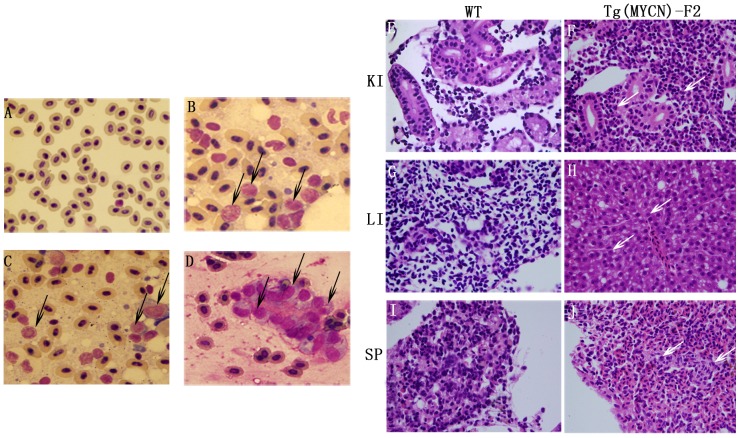
Cytological analysis of Tg(MYCN:HSE:EGFP) zebrafish.Cytology of hematopoietic cells from WT (A) and Tg(MYCN:HSE:EGFP) F0, F1, F2 generation (B, C, D) zebrafish at 60 dpf.The blood cells from WT fish were predominantly erythrocytes, with myeloid cells only occasionally observed. By contrast, erythrocytes were significantly inhibited in Tg fish, enriched for abundant blast-like cells, which are larger than the erythrocytes and have high nuclear to cytoplasmic ratios, containing multiple large nucleoli (black arrow). These blasts were similar to that of human AML peripheral blood. Transverse sections of kidney, liver, and spleen of WT (E, G and I) and Tg(MYCN:HSE:EGFP) F2 generation (F, H and J) zebrafish. Using HE staining, it showed that massive immature hematopoietic cells infiltrated in these organs of Tg fish (white arrow). KI, kidney; LI, liver; SP, spleen. (×1,000)